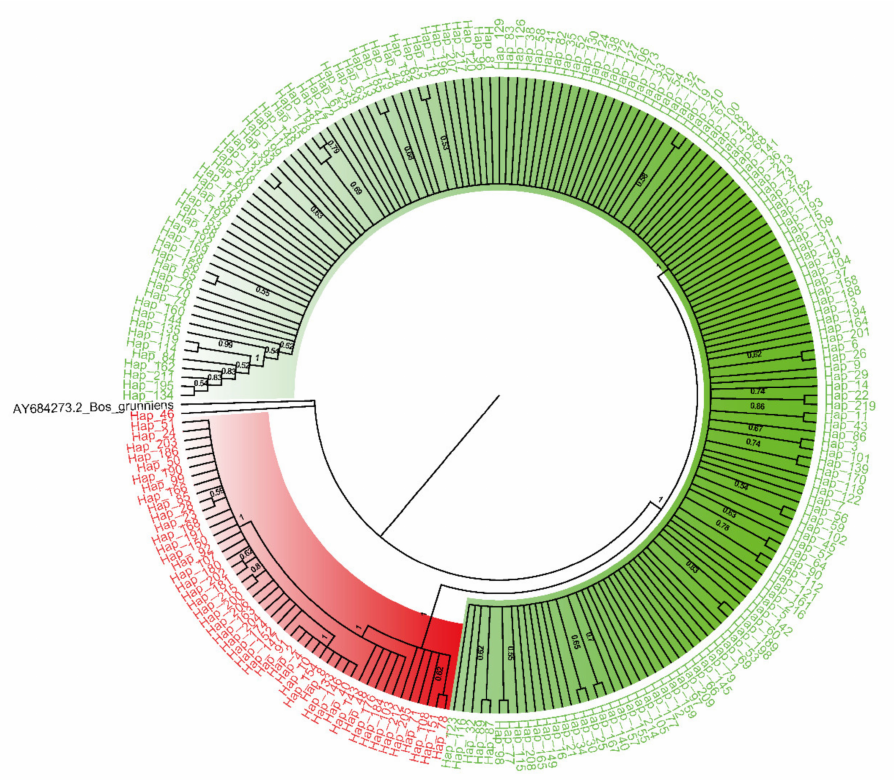
Figure 2. NJ phylogenetic tree of haplotypes of all ovary samples (red, HG1; green, HG2; black, Bos grunniens ). The values on the branches represent the confidence level (frequencies of occurrence in 1000 replicates) supported by bootstrap method.